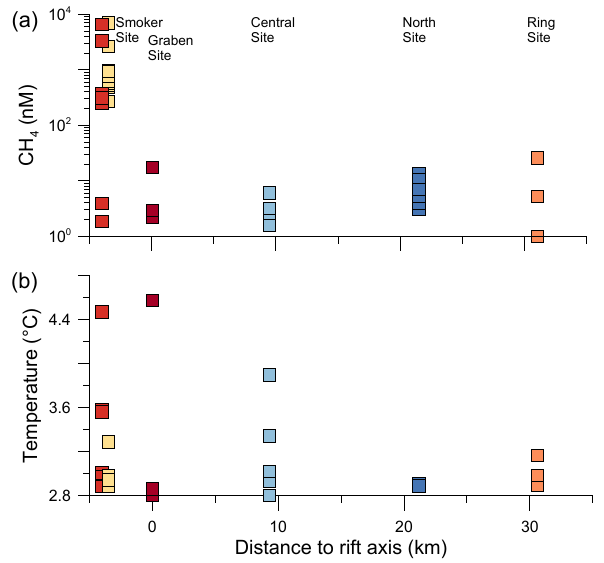
Figure 9. Water column CH 4 (a) and temperature (b) at cold seeps as well as the Smoker and Graben sites relative to the rift